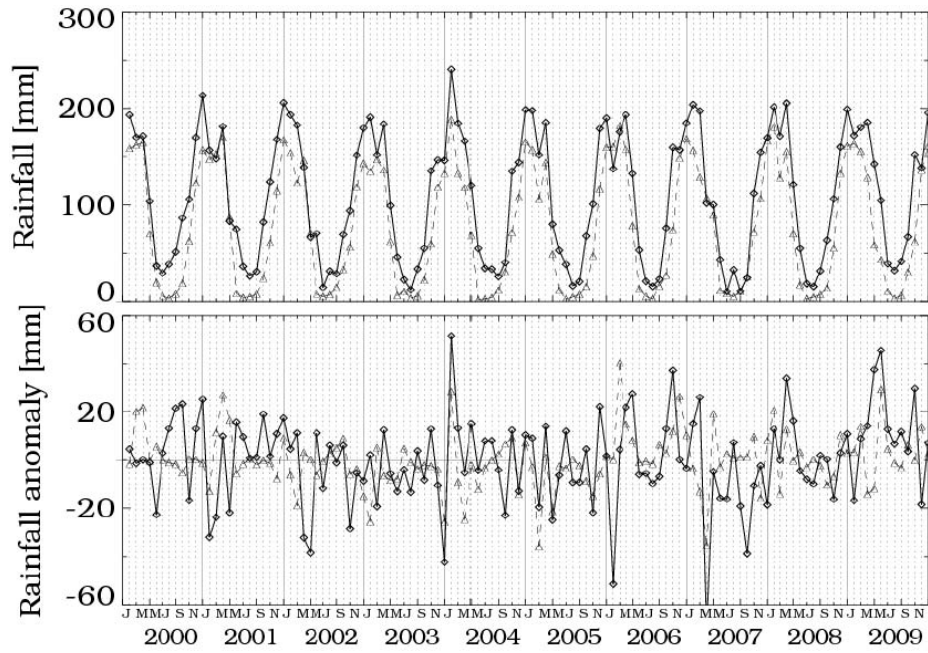
Fig. 5. Rainfall amount (top), and rainfall anomaly (bottom) for SA (solid line) and CA (dashed line) for the period 2000–2009. See text for